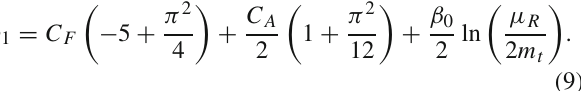
scales from m γγ / 2 to 2 m γγ varies the cross section by about 20%. For a better understanding of the behavior of the cross sec- tion, we plot in Fig. 2 the gg → γ γ amplitudes in a complex plane for { λ i } = + + ++ in the J = 0 channel, by